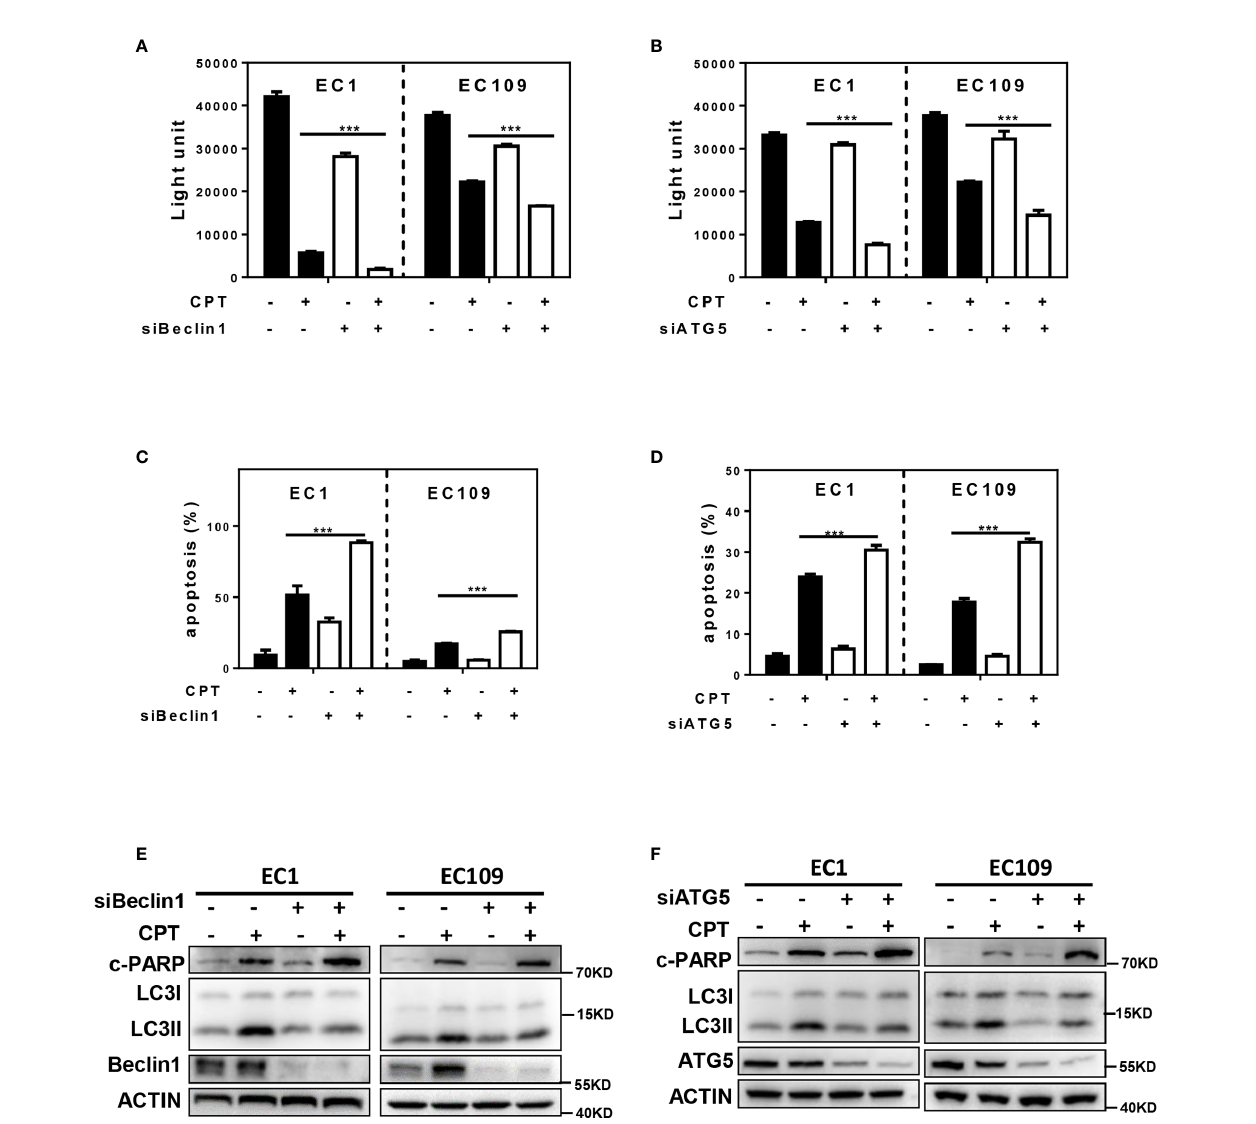
FIGURE 2 | CPT-induced autophagy was a survival signal in esophageal cancer cells. (A, B) The proliferation inhibition by CPT treatment was signi fi cantly increased by simultaneously blocking autophagy with siBeclin1 or siATG5. The combination of siBeclin1 or siATG5 with CPT in EC1 and EC109 cells signi fi cantly increased proliferation inhibition by ATPLite assay ( n = 3). (C, D) Blocking of autophagy pathway by Beclin1 or ATG5 siRNA silencing ampli fi ed CPT-induced apoptosis. The combination of siBeclin1 or siATG5 with CPT in EC1 and EC109 cells signi fi cantly increased apoptosis by Annexin V-FITC/PI double-staining analysis ( n = 3). (E, F) Beclin1 or ATG5 knockdown increased cleaved PARP expression induced by CPT. Cells were transferred with siRNAs against Beclin 1 (E) or ATG5 (F) for 48 h, and then treated with CPT at 2.5 m mol/L for 24 h. Knockdown ef fi ciency and cleaved PARP were assessed by IB analysis. Data were presented as mean ± S.E.M. *** P <